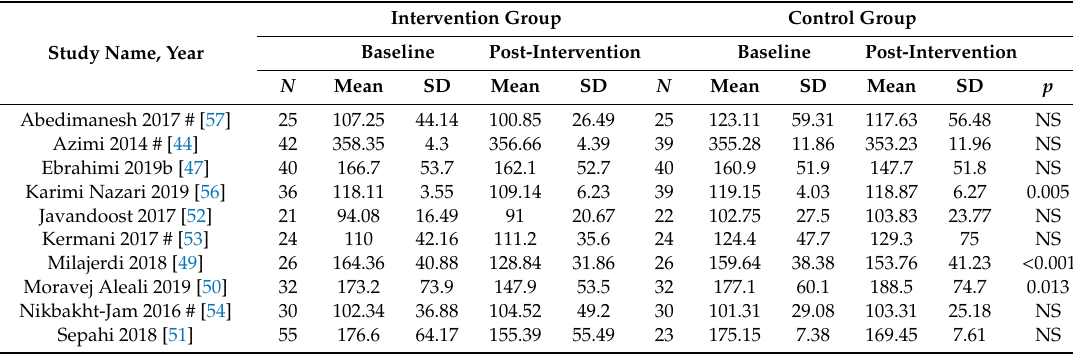
Table 2. Summary of findings for fasting blood glucose (FBG).